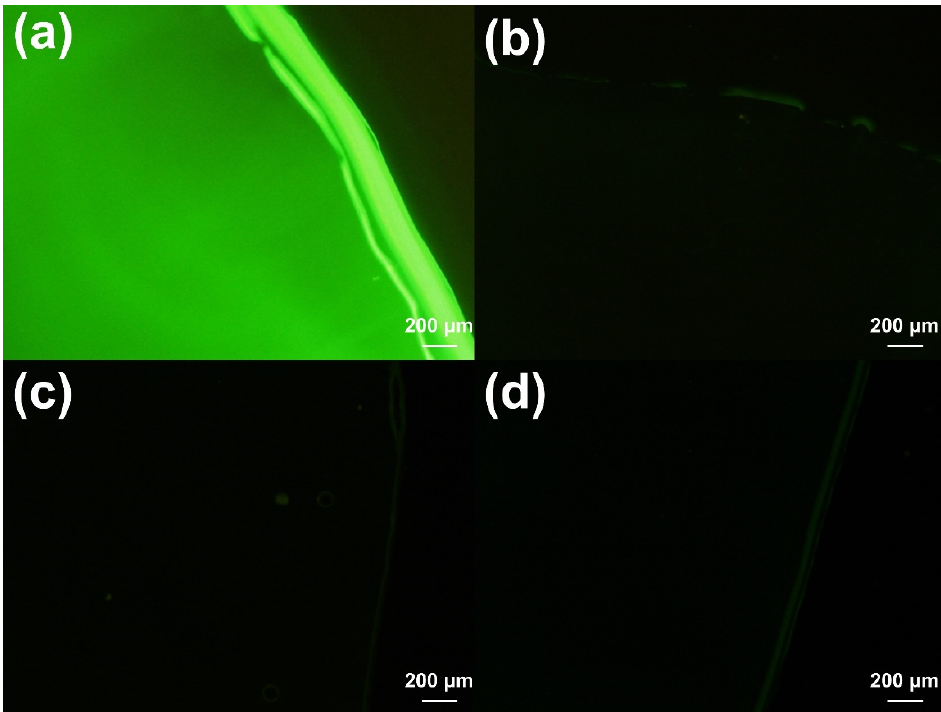
Figure 3. Fluorescence microscope images of ( a ) bare agarose hydrogel, ( b ) PeptoidCB 24 -1 hydrogel, ( c ) PeptoidCB 49 -1 hydrogel, ( d ) PeptoidCB 69 -1 hydrogel immersed in FITC-labeled BSA solution for 1 h.